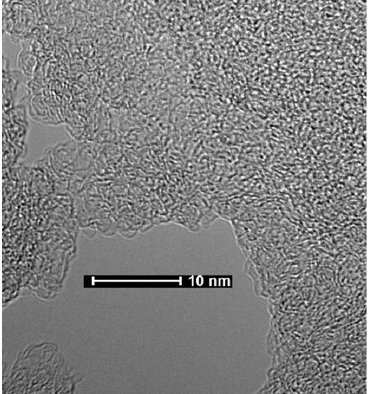
Figure 12. TEM micrograph of sucrose char after 0.25 s at 2600 °C.